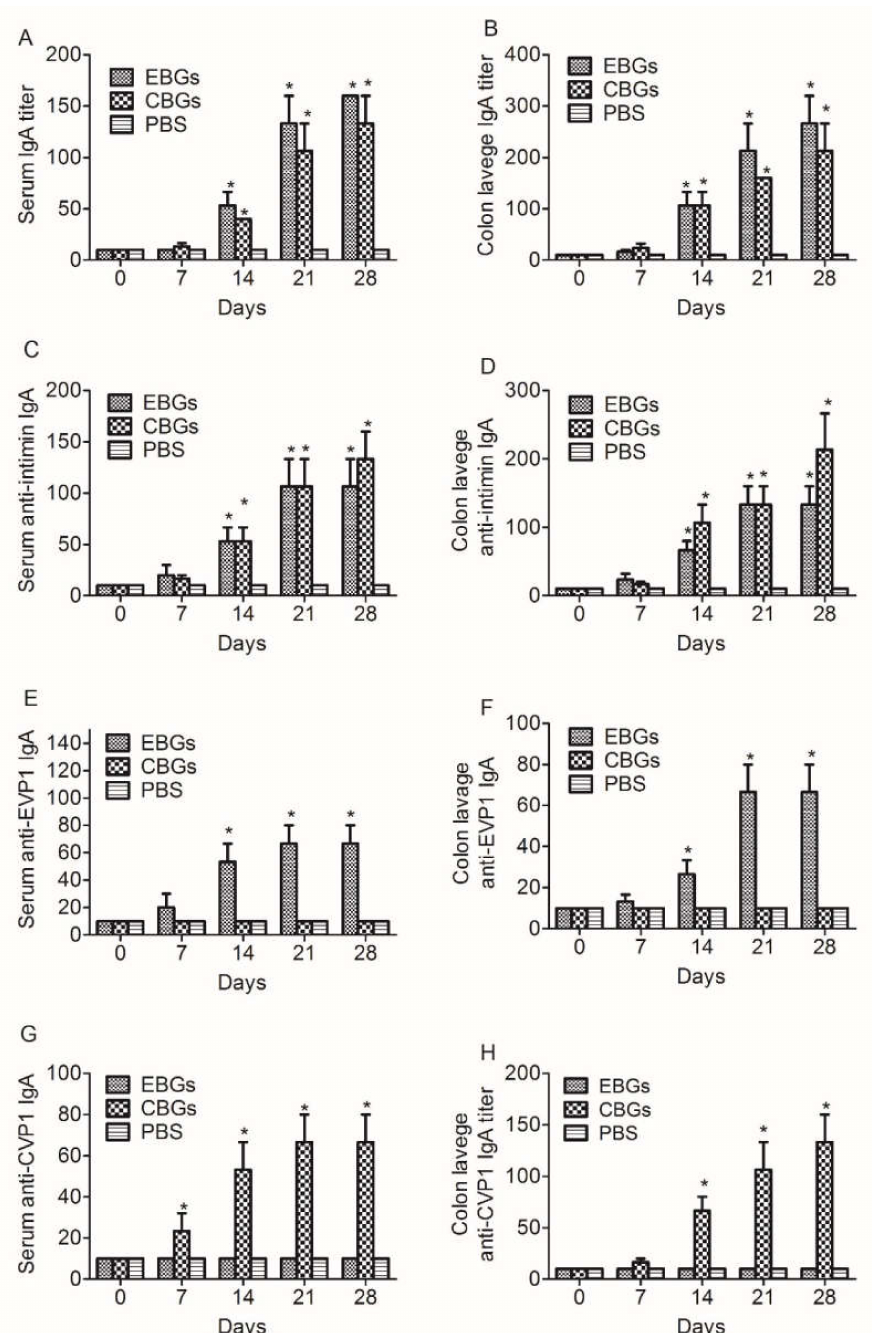
Figure 2. Detection of specific IgA titers in the sera and irrigating solution of immunized mice. Mice were inoculated intragastrically with BGs. Mice that received a PBS injection were negative controls. The IgA levels in the serum and irrigating solution specific to OBGs ( E. coli O157:H7 EDL933 strain without pOEVP1 or pOCVP1 plasmids) were measured for specific proteins (intimin, EVP1, and protein CVP1)